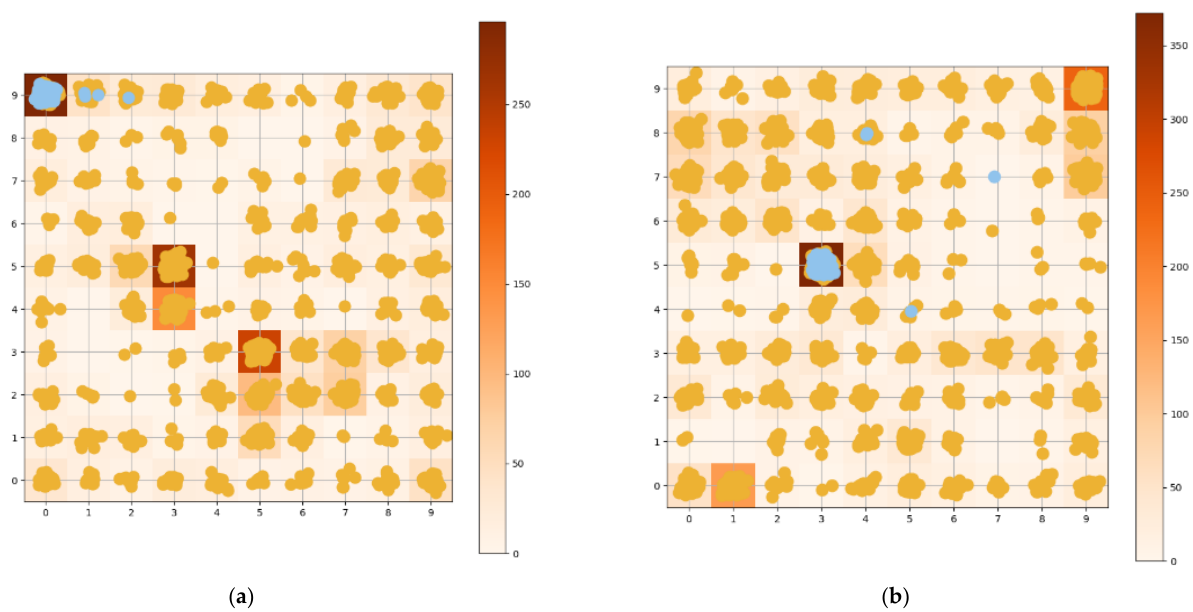
Figure 9. ( a ) SOM representation of barrier machine opening current waveforms; ( b ) SOM representation of barrier machine closing current waveforms.